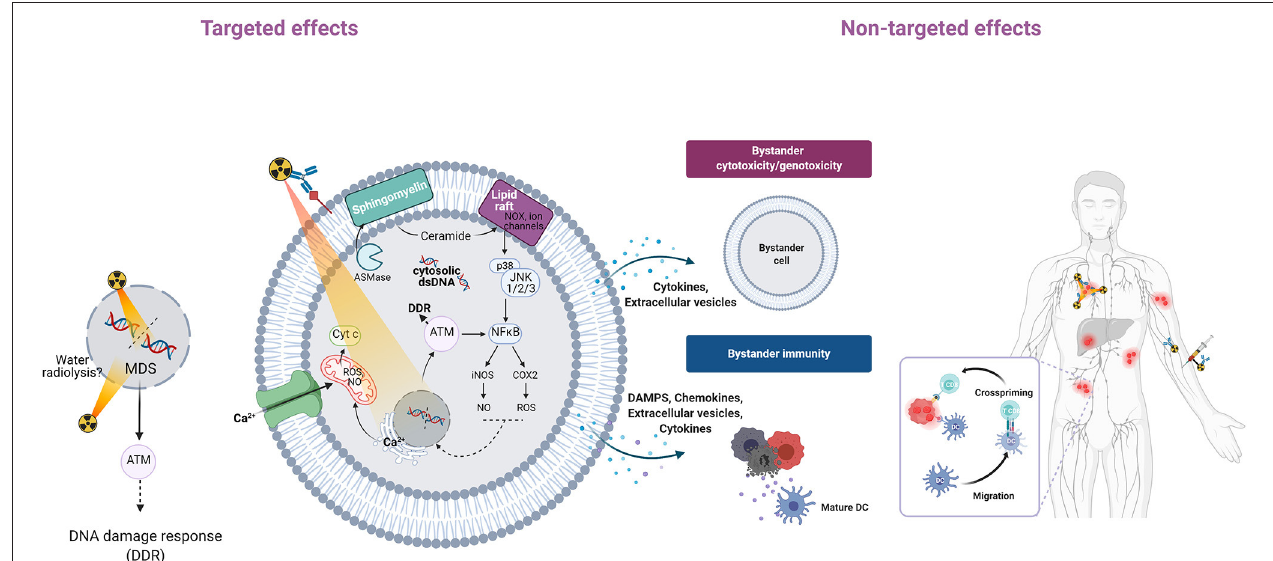
FIGURE 1 | Overview of targeted and non-targeted effects of radiation. Alpha-particle irradiation of a cell population can induce targeted effects (in cells hit directly by particles) and non-targeted effects (in non-irradiated cells). Non-targeted effects can be detected at short distance (bystander effects) or at long distance (systemic effects). Genomic instability, another class of non-targeted effects, is not described here. In irradiated cells (targeted effects), alpha particles induce DSBs and non-DSB clustered DNA lesions (MDS) that are detected by ATM and activate the DNA damage response (11, 12). Alpha-particle irradiation of the cell membrane generates lipid peroxidation products (4-HNE, 4-hydroxy-2-nonenal; MDA, malondialdehyde) from polyunsaturated fatty acids (PUFA) ( 43). Alpha-particle irradiation can also activate acid sphingomyelinase (ASMase) and this leads to the rapid formation of ceramide through hydrolysis of sphingomyelin, a cell membrane phospholipid ( 38, 42). Ceramide-enriched large domains (lipid rafts) are formed by aggregation of ceramide, leading to activation of the mitogen-activated protein kinase (MAPK) pathway and its downstream effector, nuclear factor kappa B (NF- κ B) (41). NF- κ B induces the transcription of target genes, such as those encoding cytokines, COX-2, and inducible nitric oxide synthase (iNOS), followed by production of ROS and nitric oxide (NO) that contribute to oxidative stress ( 44). Irradiation can also increase the intracellular Ca 2 + level ( 45) through release from the endoplasmic reticulum via calcium release mechanisms (46). Ca 2 + can in turn activate protein kinase C, the MAPK pathway and transcription factors (NF- κ B, AP1) that promote various downstream pathways (iNOS, COX-2). Mitochondria also are affected by alpha-particle irradiation ( 47–52). Ca 2 + can be taken up by mitochondria, leading to ROS and RNS increase, mitochondrial DNA damage, altered ATP synthesis, mitochondrial depolarization, and release of cytochrome C and caspase 3. Mitochondrial fission also has been observed. Targeted cells can communicate with bystander cells through gap junctions or through the release of soluble factors. Extracellular vesicles, including exosomes, containing nucleic acids, lipids and proteins, might be released, and contribute to bystander immunity. Systemic effects may involve the immune system through the release of DAMPs that are recognized by antigen-presenting cells (e.g., dendritic cells, DC, that present antigenic peptides to CD4 + and CD8 + T lymphocytes for immune response activation). Altogether these effects contribute to tumor cell